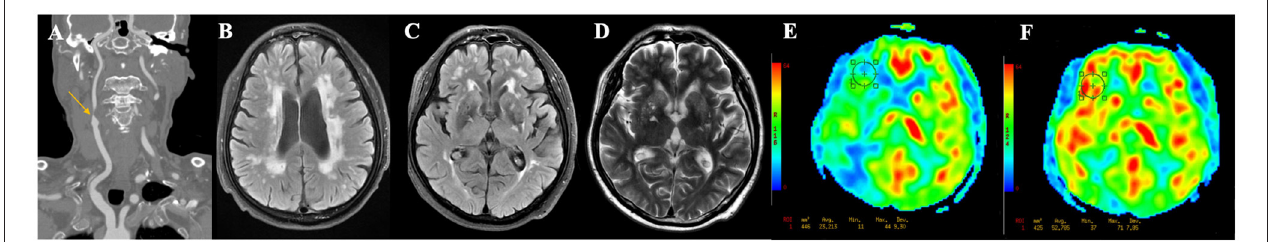
FIGURE 3 | A representative case of cerebral hyperperfusion. (A) Pre-operative computed tomography angiography shows severe stenosis of the right carotid artery. (B–D) Pre-operative T2WI and FLAIR show severe white matter hyperintensities (Fazekas score = 6), multiple lacunes in bilateral basal ganglia, and category-3